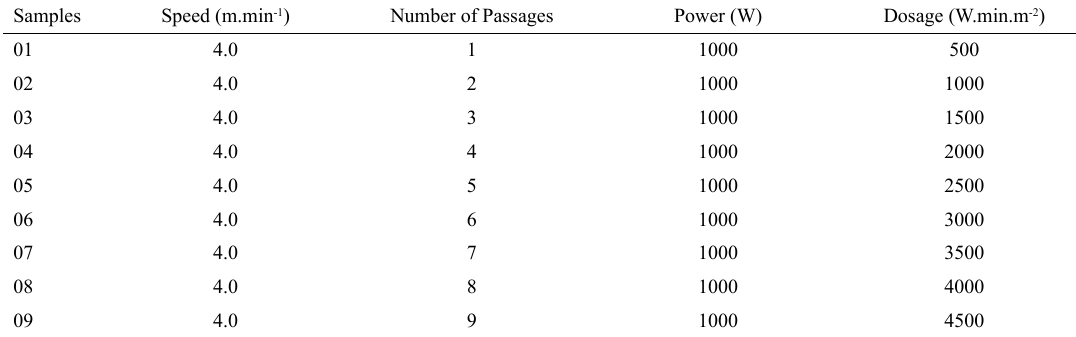
Table 2. Dosage applied on polyamide substrates.